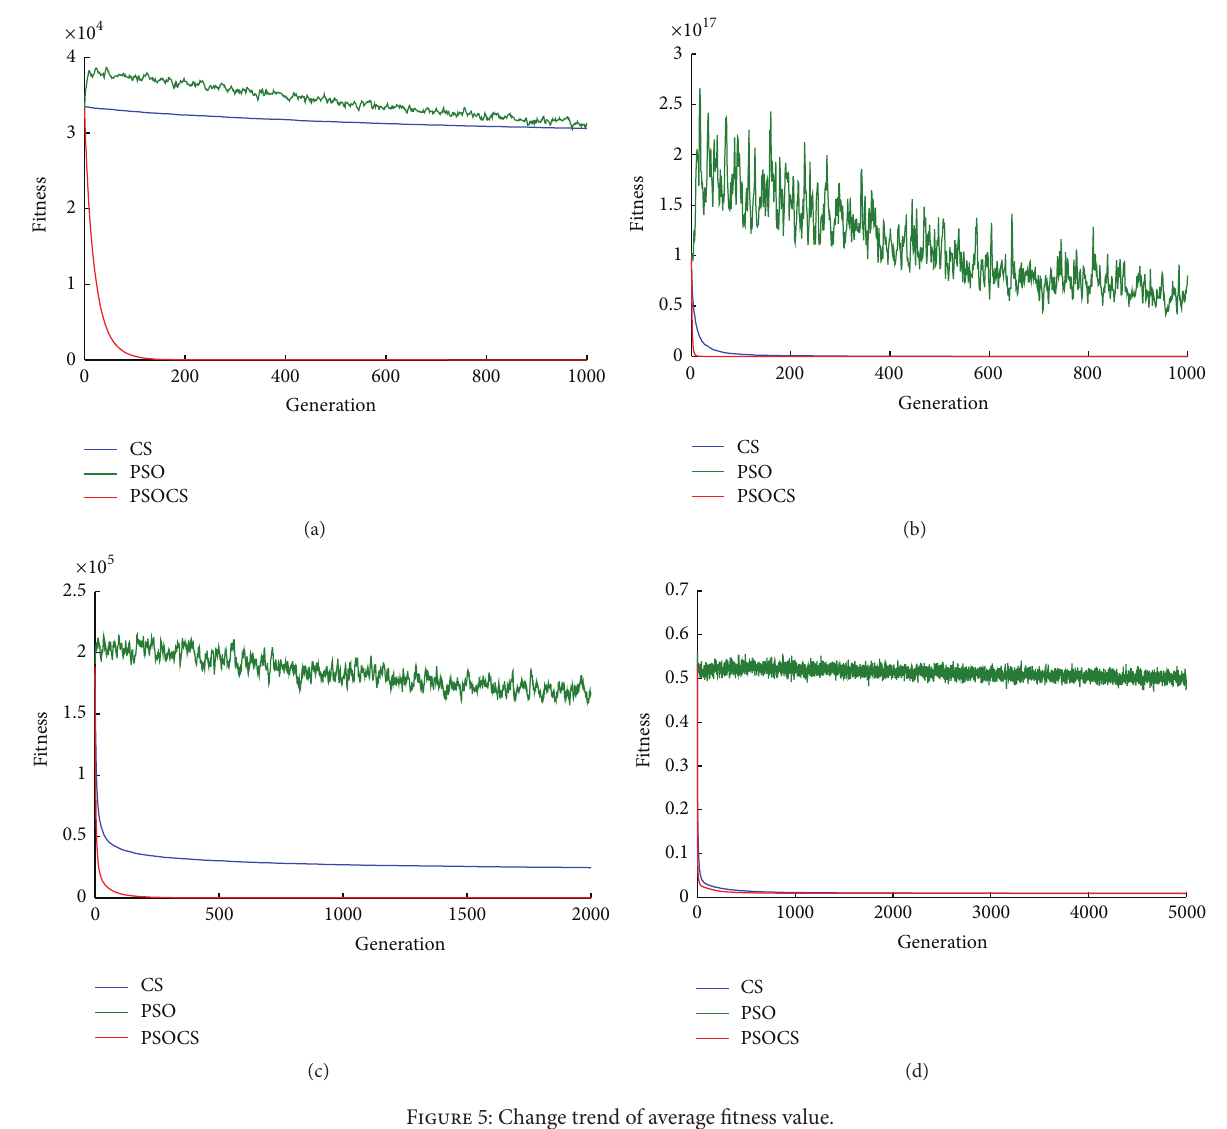
Figure 5: Change trend of average fitness